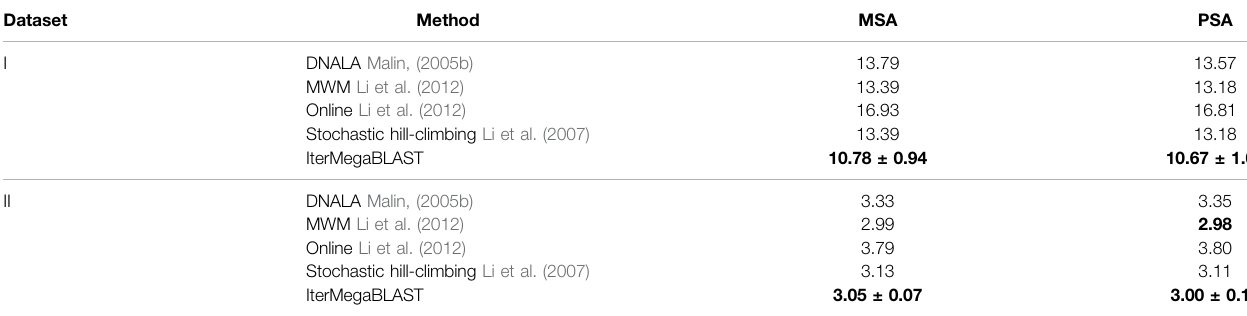
TABLE 2 | Comparing IterMegaBLAST with state-of-the-art genomic privacy-protection methods. m ± n denotes (mean)±(standard deviation). The performance is measured by the average distance between DNA sequences and their obfuscated sequences. The shorter the distance is, the less the information loss. MSA, multiple sequence alignment; PSA, pairwise sequence alignment.